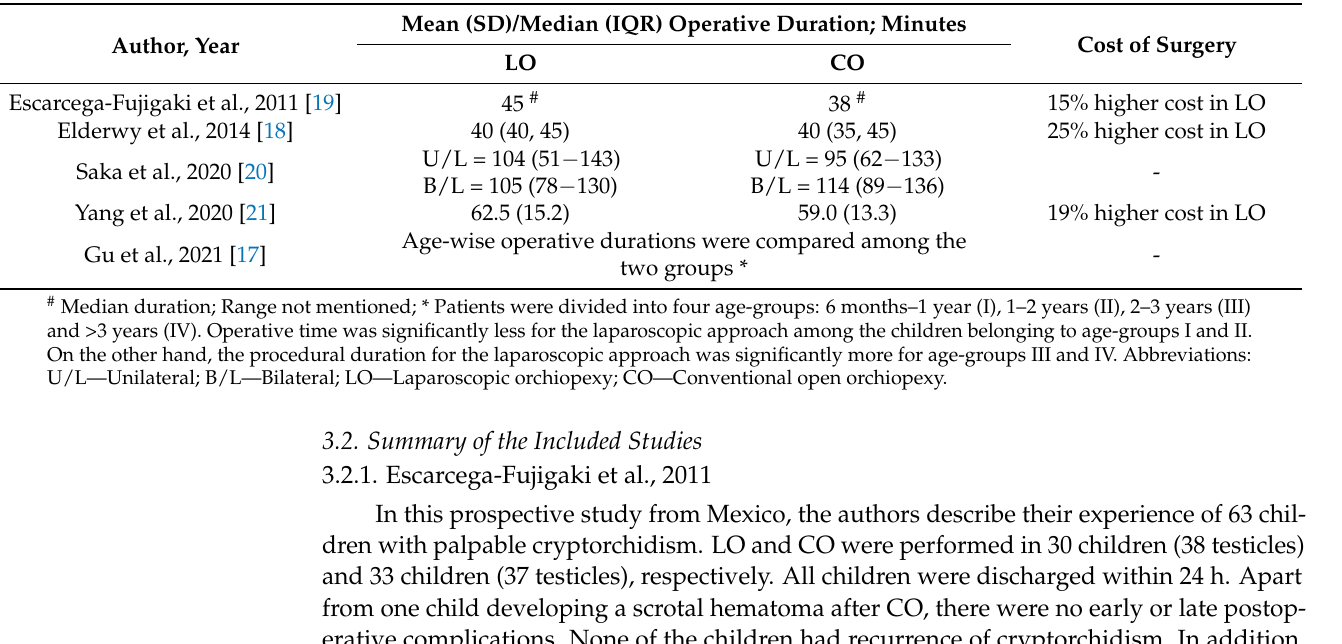
Table 2. Comparison of the operative duration and cost of the surgery among the